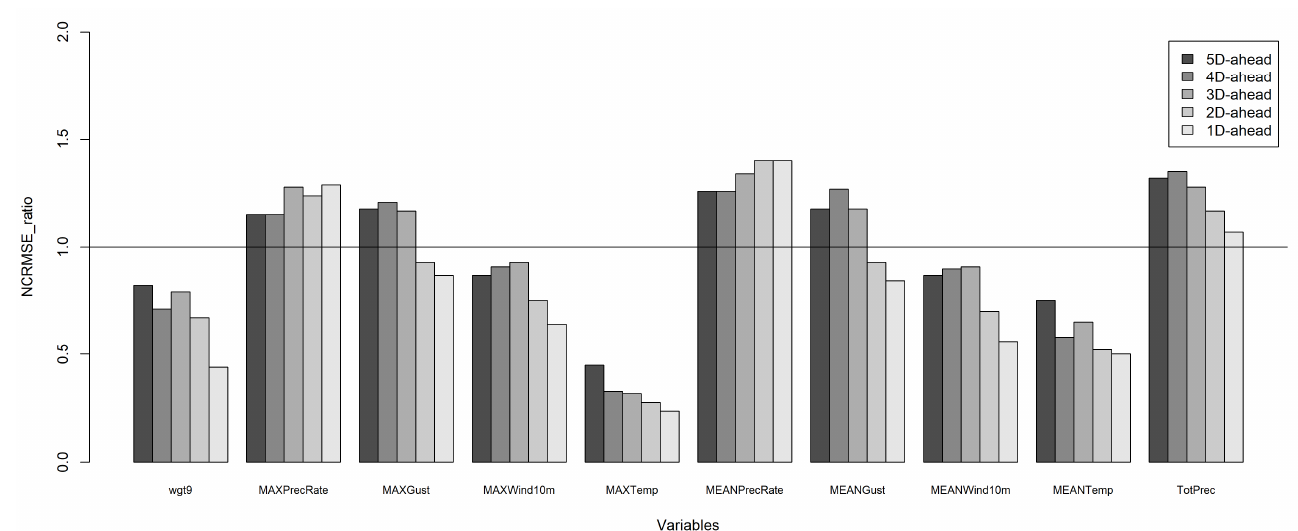
Figure 7. NCRMSE ratio of weather variables to outage prediction for different lead times.